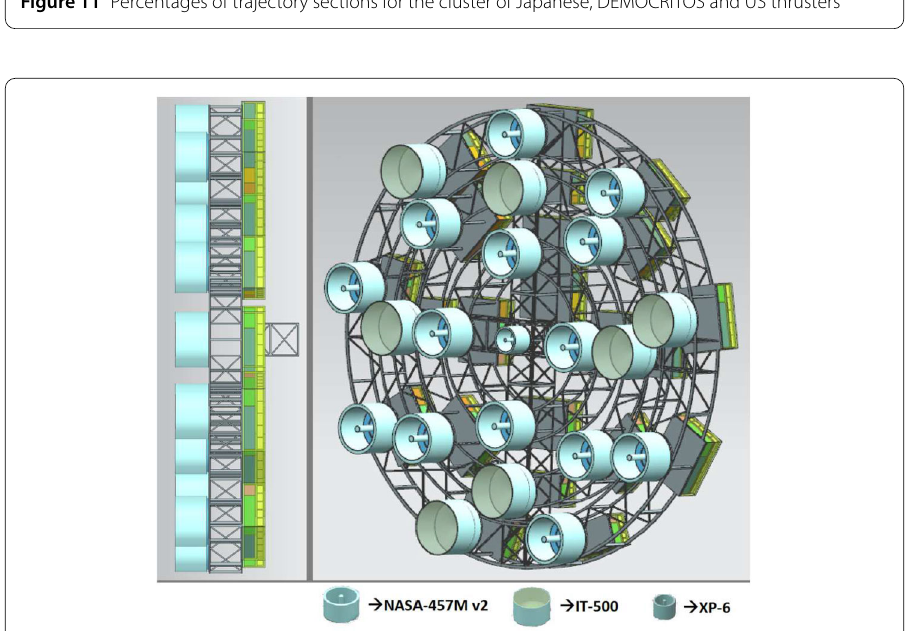
Figure 12 CAD design of gridded cluster plate including Japanese, DEMOCRITOS and US electric thrusters with redundant PPUs for each thruster at the